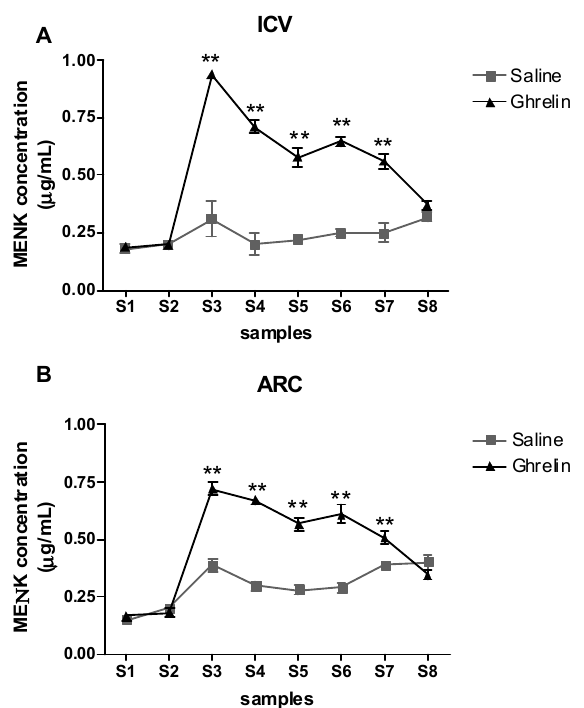
Figure 4. ( A ) Time courses of the met-enkephalin (MENK) dialysate levels determined before, during and after the formalin test in animals treated with Saline-ICV or Ghrelin-ICV. ( B ) Time courses of the MENK dialysate levels determined before, during and after the formalin test in animals treated with Saline-ARC or Ghrelin-ARC. Data are mean ± SEM. ** p < 0.001 and * p < 0.05 vs. other group, same time period.